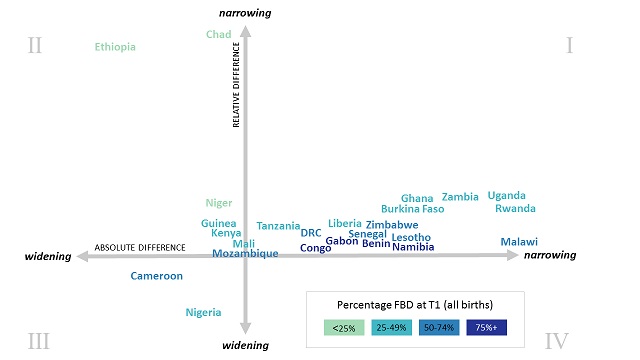
Typologies of change in absolute and relative difference of faculty-based deliveries (FBD) between wealthiest and poorest quintiles from T1 (2000-2007) to T2 (2008-2016), chart not to scale.